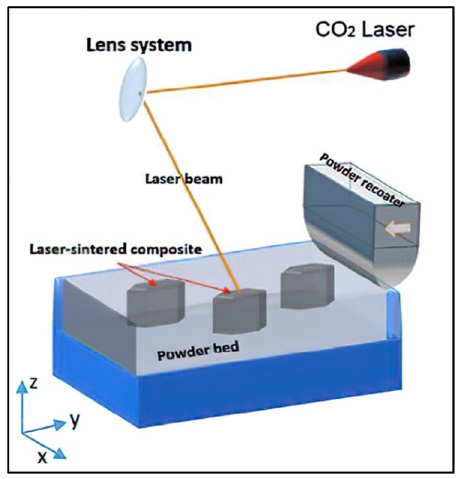
Figure 3: Selective laser sintering